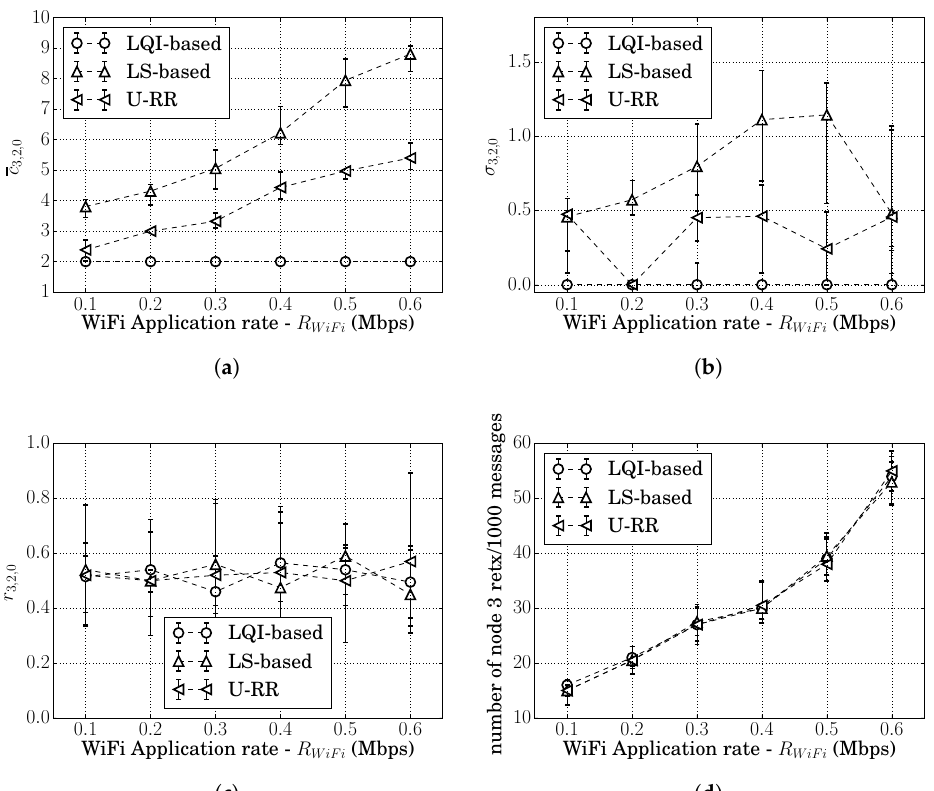
Figure 6. The median and the 15th to 85th percentiles of ( a ): the cumulative route cost of route 3,2,0 ( c 3,2,0 ), ( b ): the standard deviation of the estimated costs measured at node 3 for the route 3,2,0 ( σ 3,2,0 ), ( c ): the ratio of times that route 3,2,0 was chosen ( r 3,2,0 ), and ( d ): the number of times that node 3 had to retransmit for every 1000 messages for the symmetric scenario